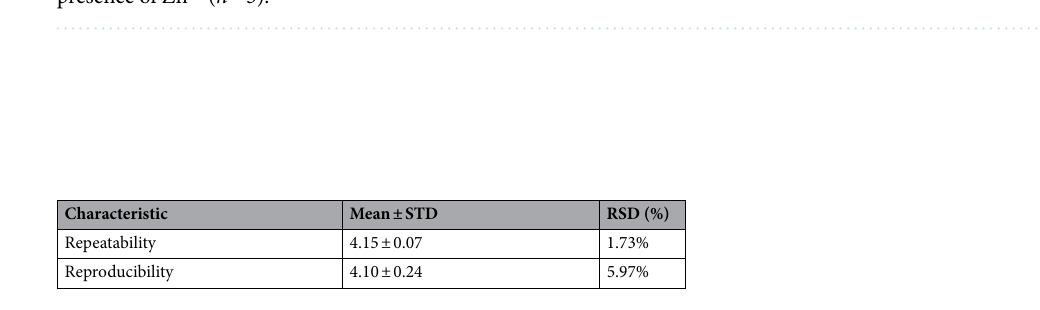
Table 3. RSD of repeatability and reproducibility of modified